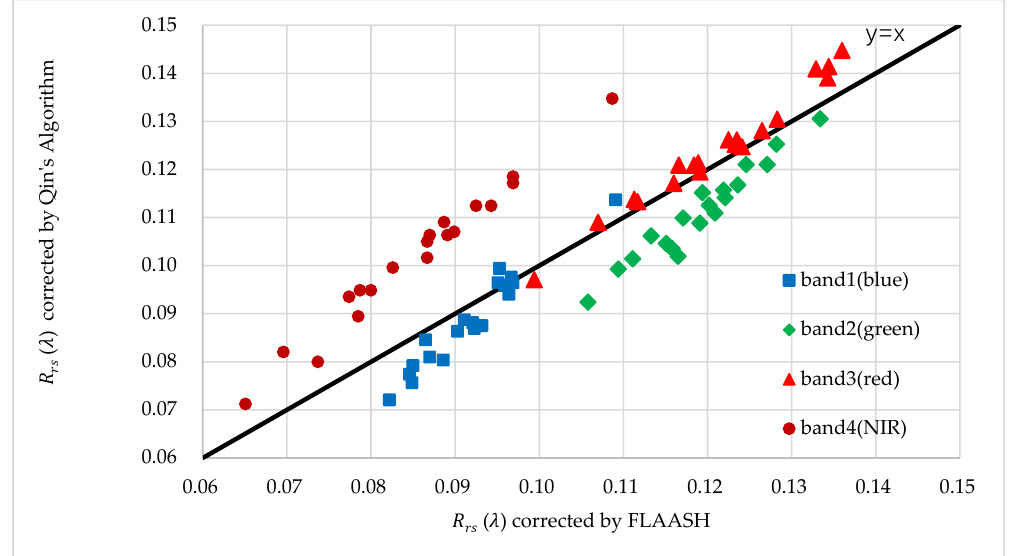
Figure 11. Water leaving reflectance ( R rs ( λ )) of GF-1 remote sensing data at each sampling site.